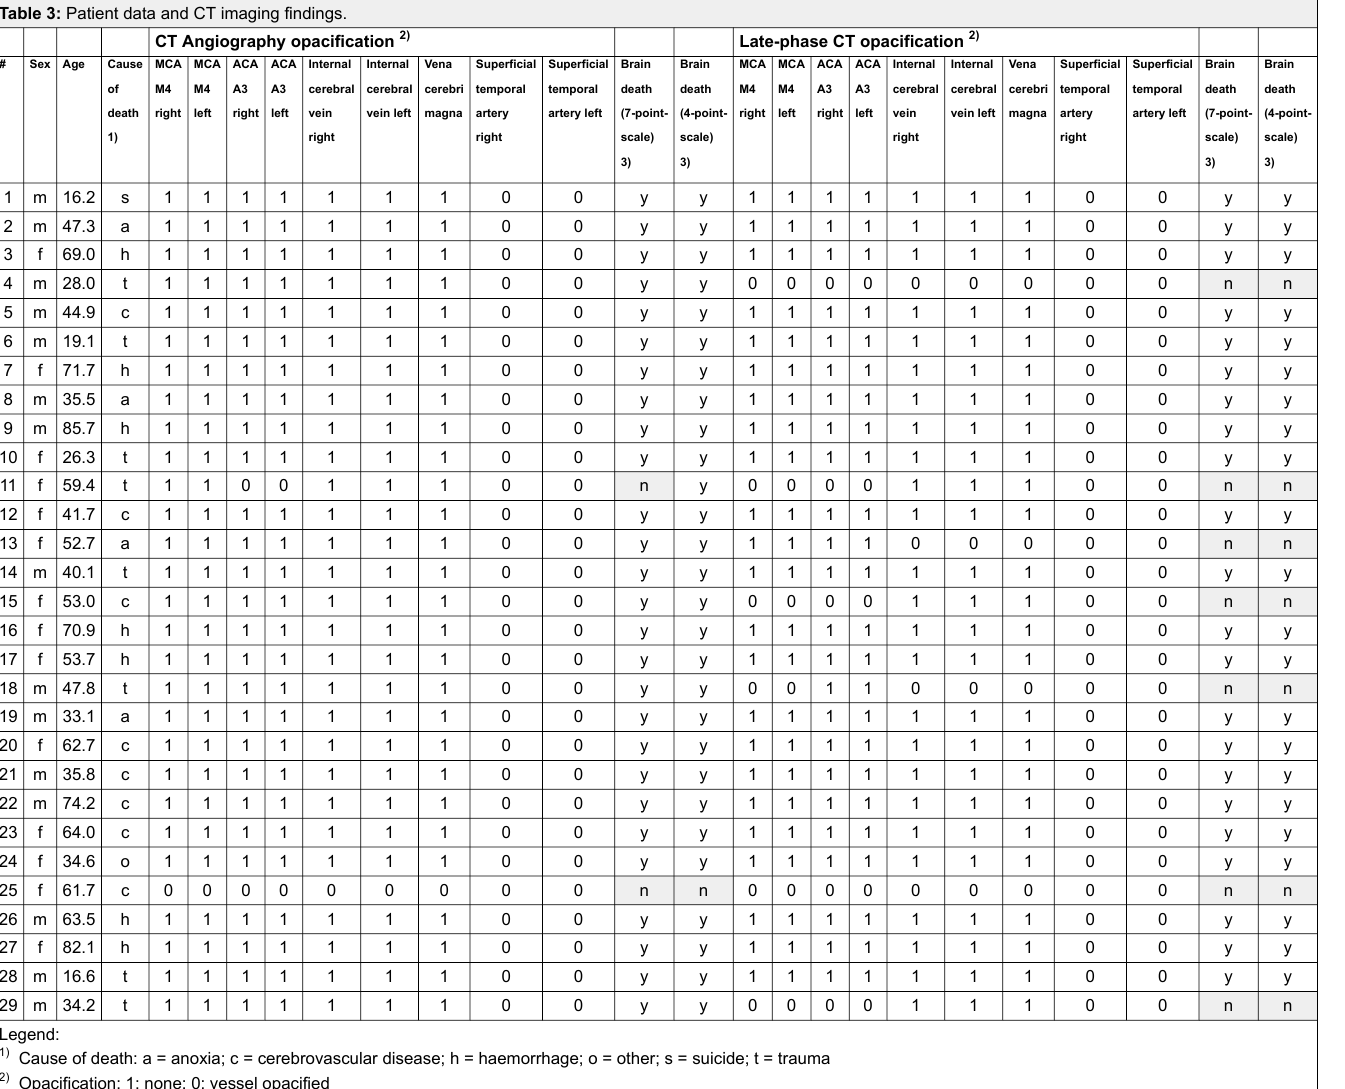
Table 3: Patient data and CT imaging findings. CT Angiography opacification 2)